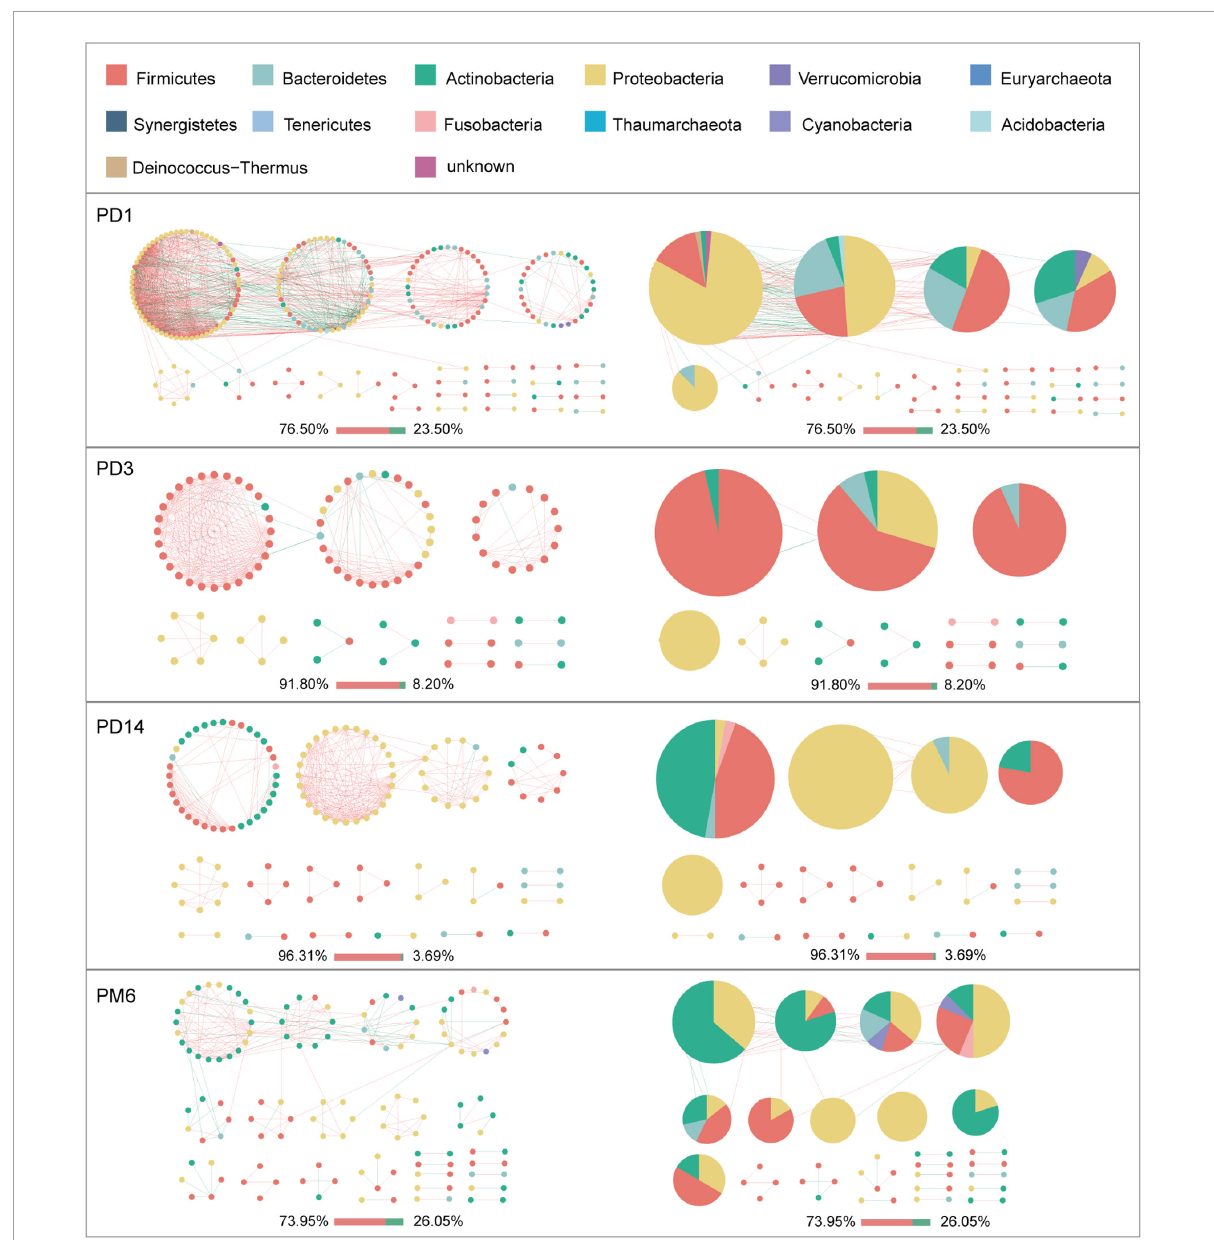
FIGURE6 Modules within gut microbial networks of infants in the probiotic group. The colors of nodes represent different major phyla; pie charts exhibit the phylum level composition of modules with ≥ 5 nodes. Red edges indicate positive correlations between nodes, whereas green edges indicate negative correlations. The bar underneath each networks demonstrate the proportion of positive and negative